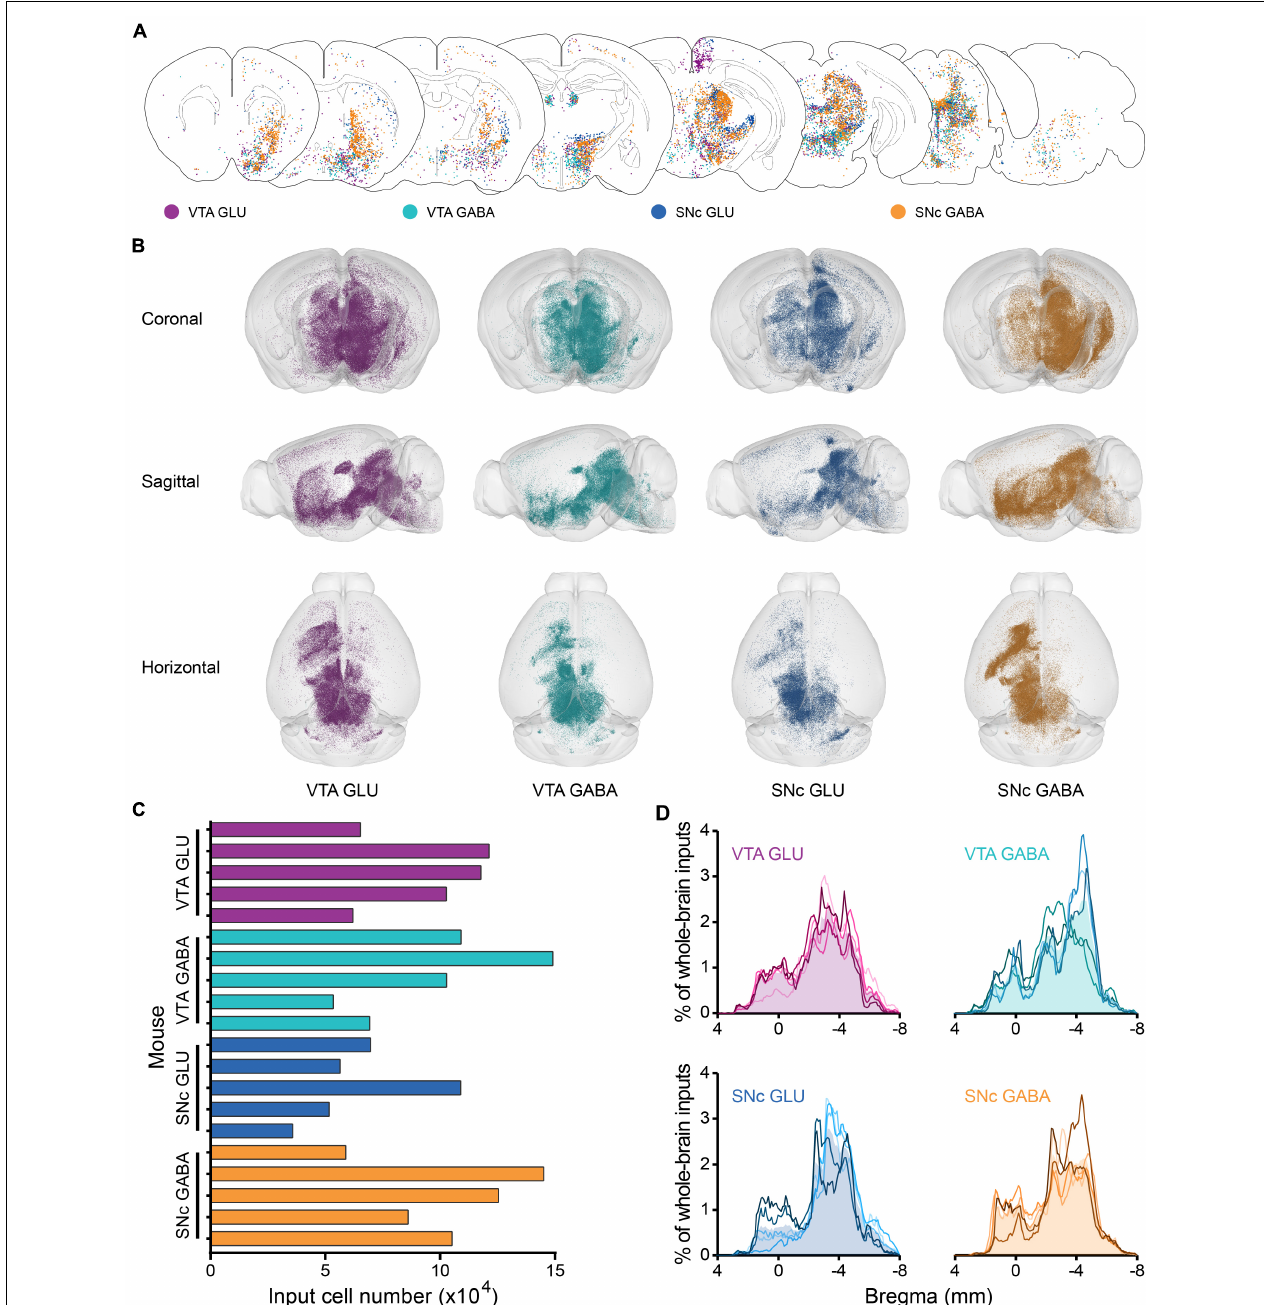
FIGURE 2 | Whole-brain monosynaptic inputs to glutamatergic and GABAergic neurons in VTA and SNc. (A) Schematic coronal sections showing labeling of monosynaptic inputs to glutamatergic and GABAergic neurons in VTA and SNc (hereafter called VTA GLU, VTA GABA, SNc GLU, and SNc GABA neurons). One dot represents one neuron. (B) 3D visualization of whole-brain monosynaptic inputs to glutamatergic and GABAergic neurons in VTA and SNc from different view. (C) Numbers of transsynaptically labeled neurons (“input neurons”), each row represents the input neurons in each mouse. (D) Whole-brain distribution of all input neurons along the A-P axis. Colored lines, input distribution for the individual mouse; colored line with the shaded area under it, average input